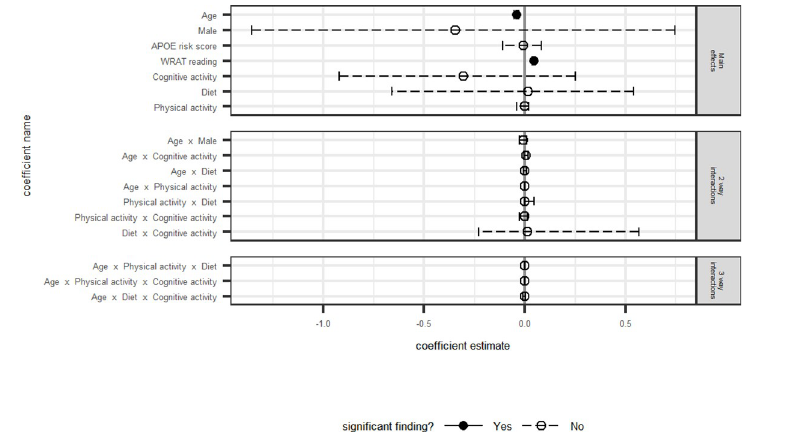
Fig 1. PACC: Model averaged regression coefficient estimates and 95% confidence intervals.